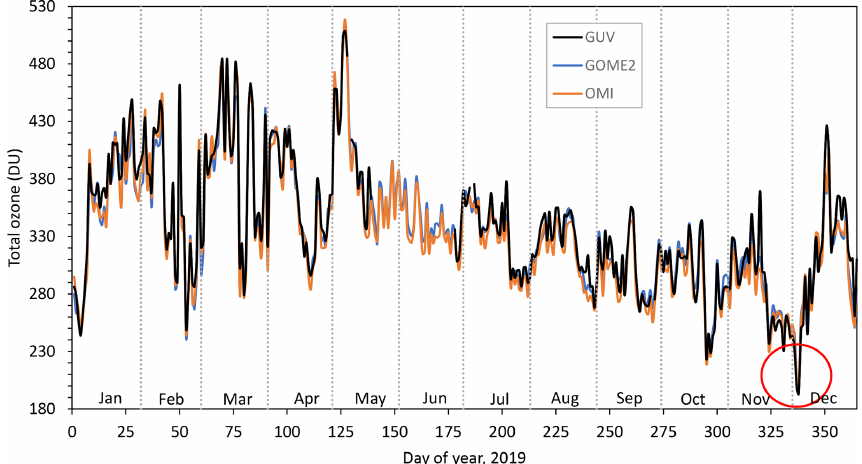
Figure 10. Total ozone column values from Oslo/Kjeller in 2019 measured with the GUV instrument (black line), OMI satellite (orange line), and GOME-2 (blue line). The red circle indicates the mini ozone hole over Scandinavia on 4 December 2019.